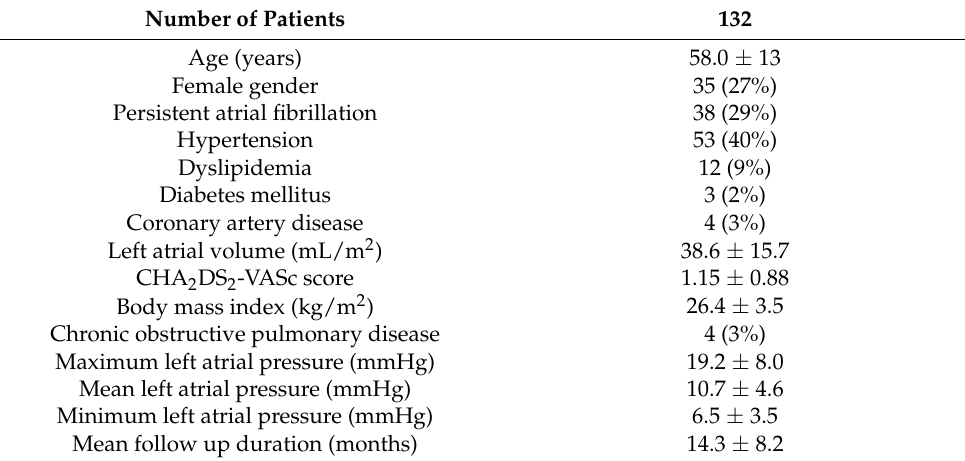
Table 1. Baseline characteristics of the study